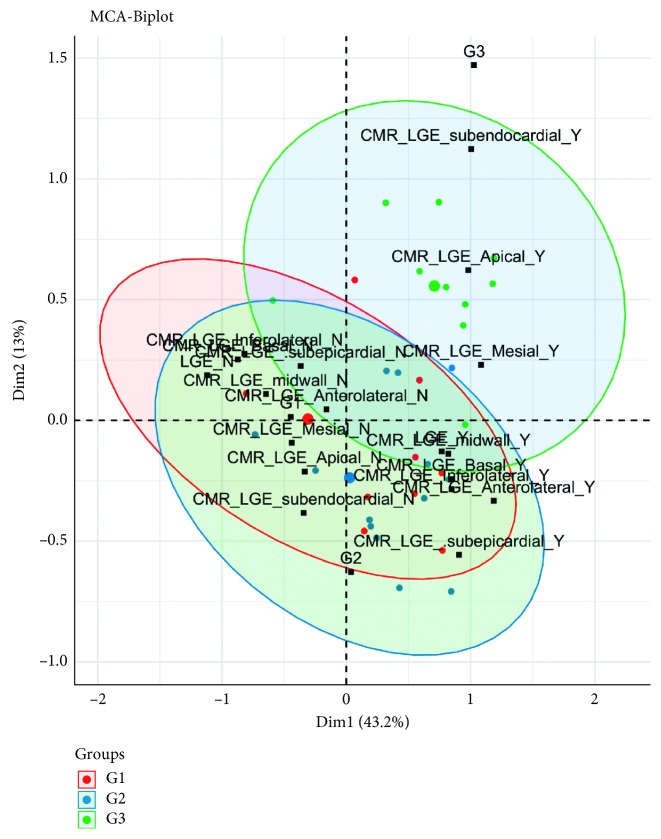
Multiple correspondence analyses of the variables associated with the presence and location of LGE within LVEF groups. It shows the difference between the variables associated with G3 versus G2 and G1 groups.